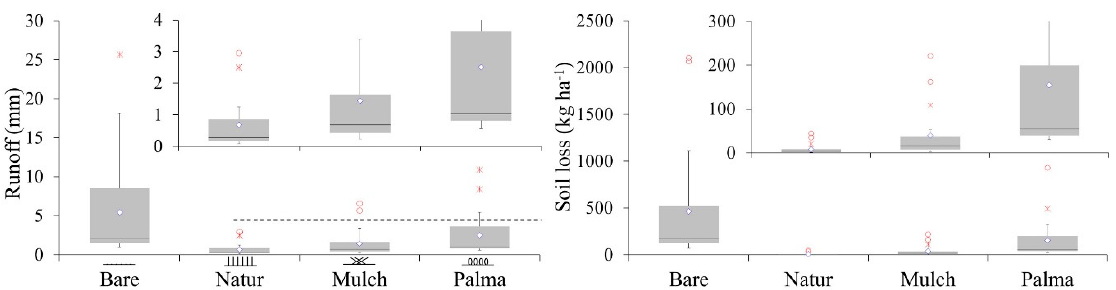
Figure 9. Box plot runoff and soil loss for all plot covers. The superimposed graphs are enlarged in order to visualize details for Caatinga, Mulch, and Palma plots. Key: ' ◊ ' average; '-' median; ' □ ' 25% to 75% probability; ' ┬ ' maximum; ' ┴ 'minimum; '*' outlier; and '°' extreme.